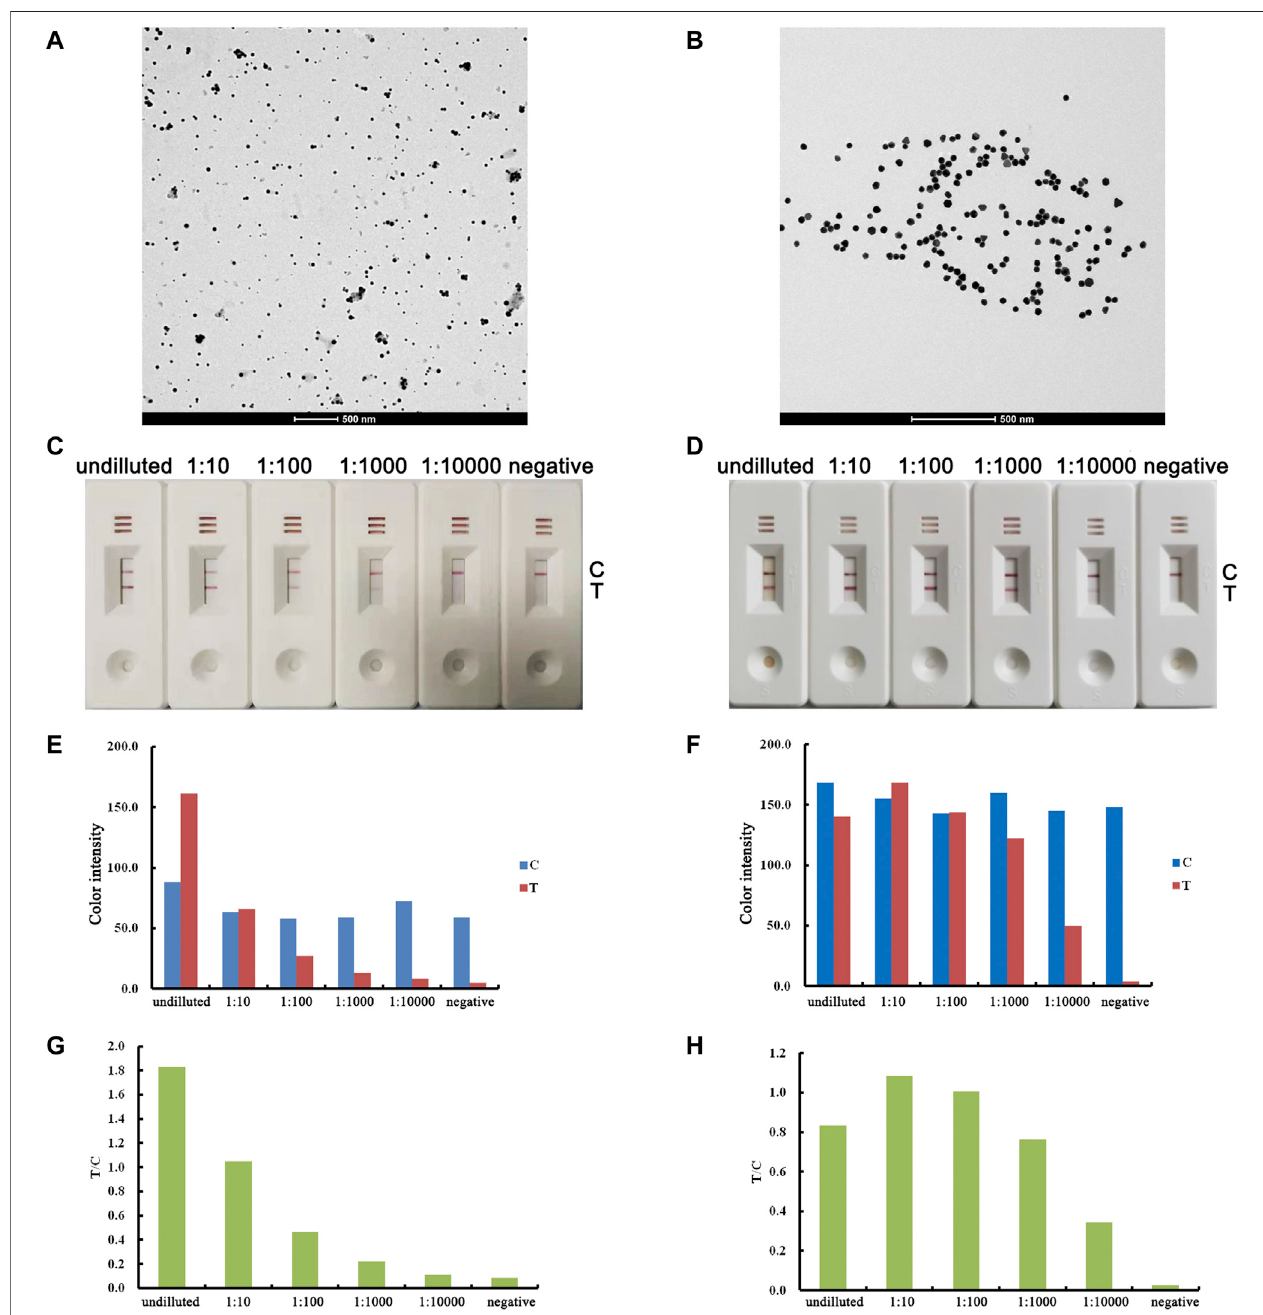
FIGURE 2 | Optimization of the AuNP label. The results for traditional AuNPs are shown in the left column, and the results for ultrauniform AuNPs are shown in the rightcolumn.TEMimagesofAuNPs (A,B) .Realdetection fi guresofsensitivityanalysisofASFVantibodybylateral fl owassay (C,D) .Thecolorintensityvaluesofthetest line (T value) and control line (C value) of the lateral fl ow assay (E, F) . The T/C value of lateral fl ow assay (G, H) .